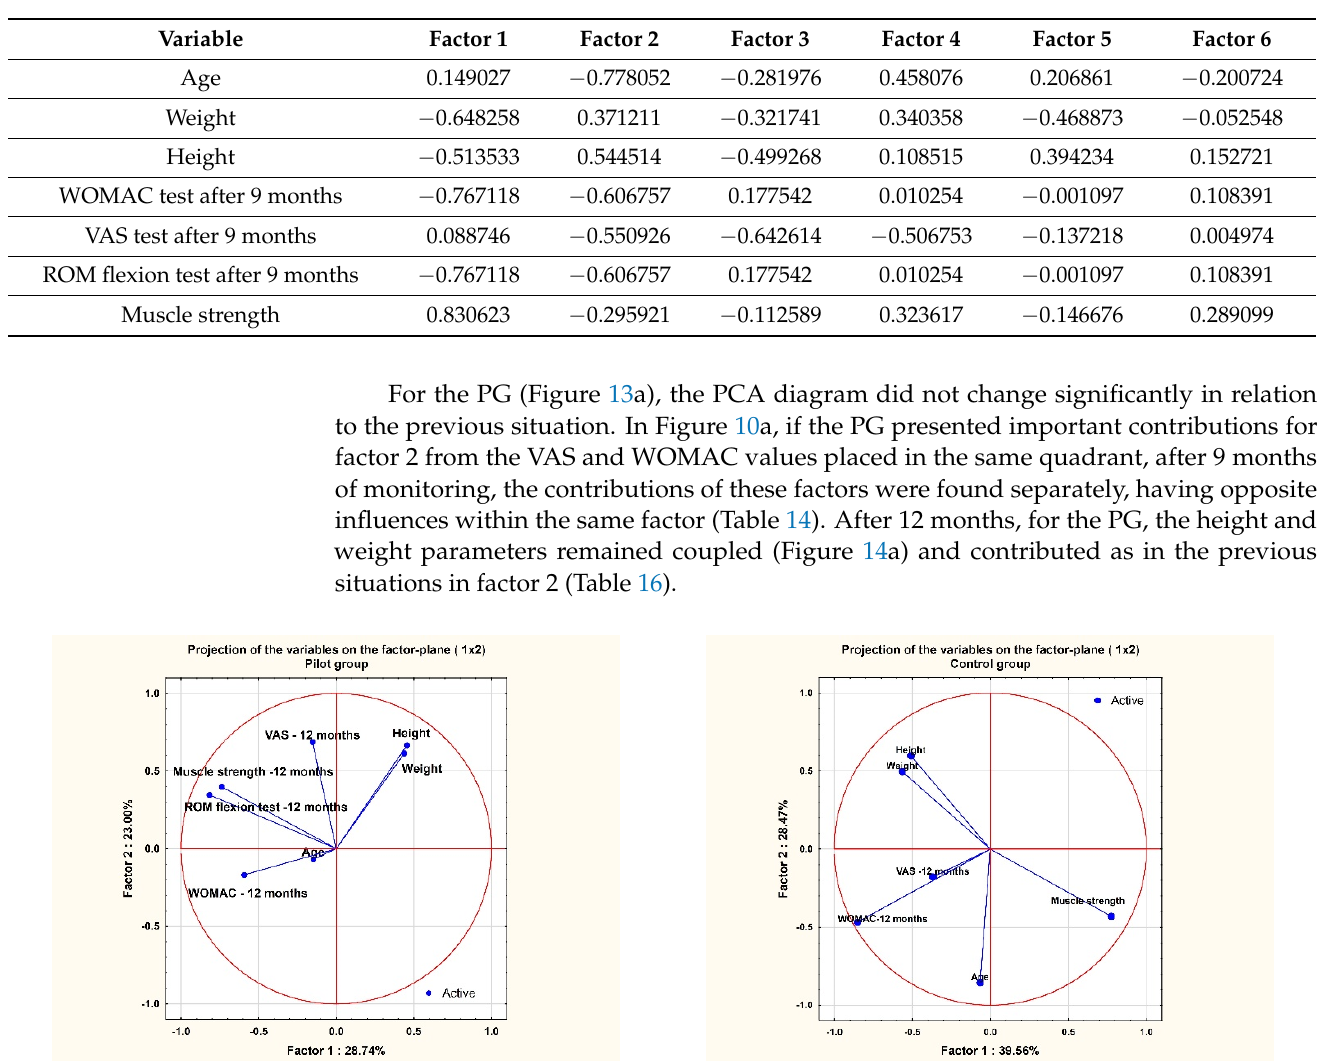
Table 15. Factor coordinates of the variables based on correlations with the control group (CG) after 9 months.